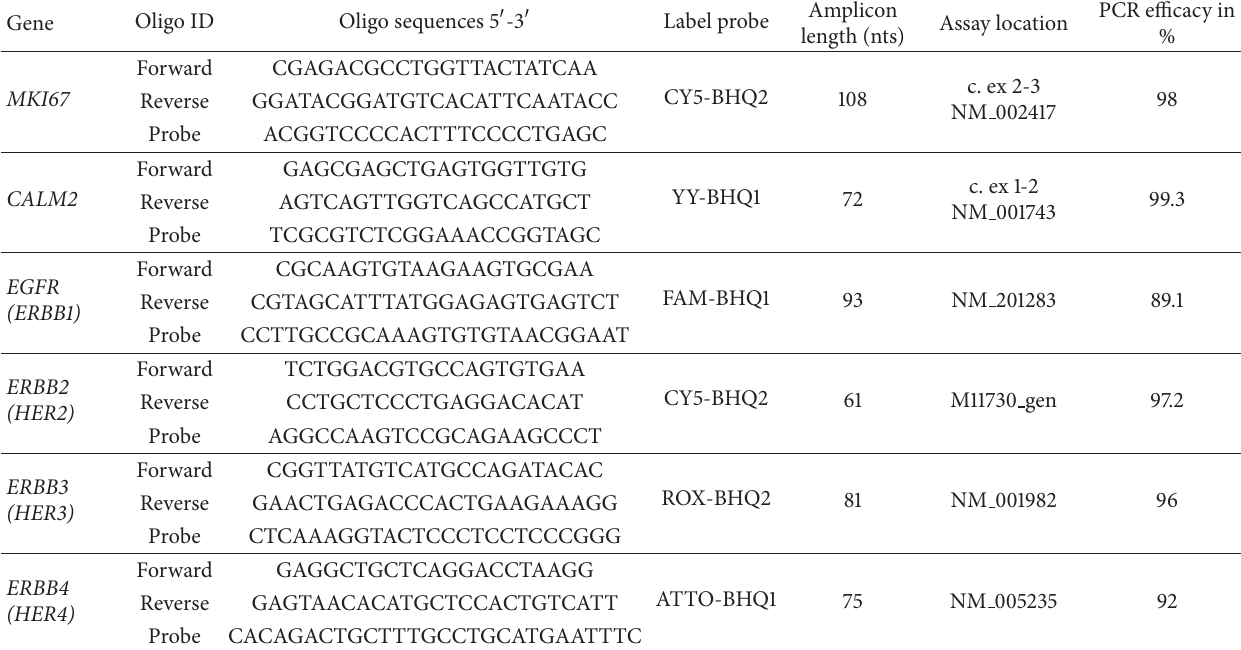
Table 1: Primer/probe sets used for amplification of the target and reference